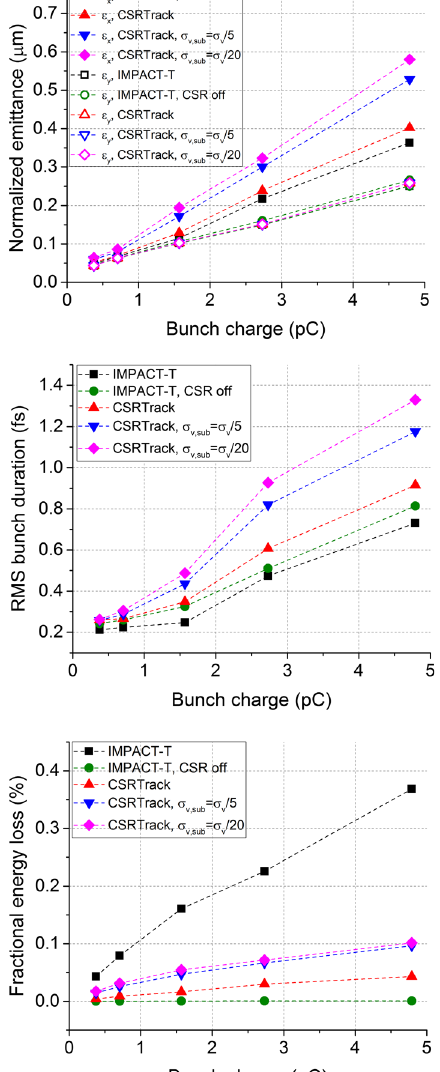
FIG. 4. Comparisons of the bunch durations, normalized emittances and energy losses at the exit of the chicane as simulated by IMPACT - T and CSRT rack . The full width of the slit is 0.4 mm. The initial parameters are summarized in Table I.